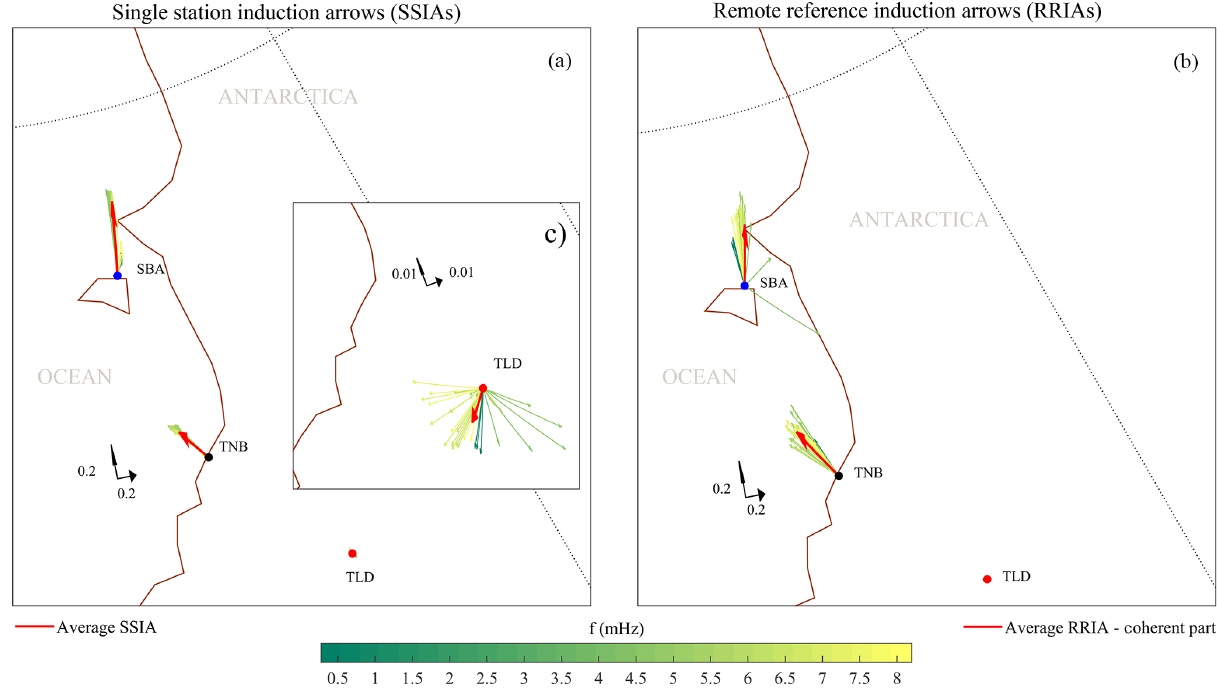
Figure 7. Single-station induction arrows at SBA, TNB and TLD (a, c) and remote reference induction arrows at SBA and TNB using TLD